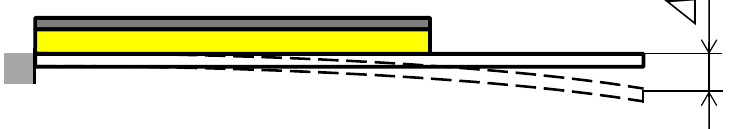
Figure 4: Sketch showing the measurement of the tip deflection,  , on the